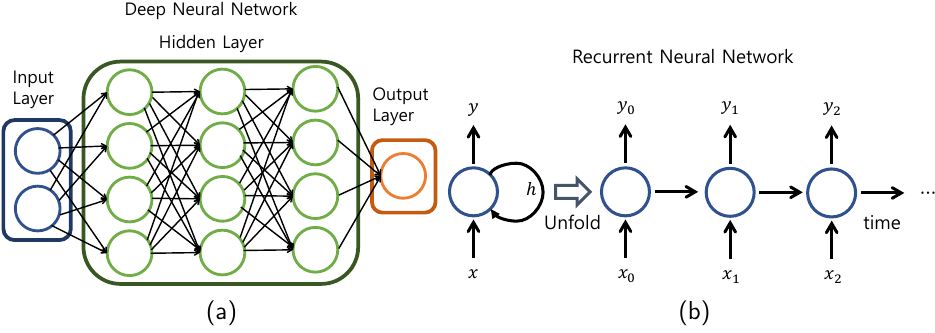
Figure 1. Structure of ( a ) a deep neural network and ( b ) a recurrent neural